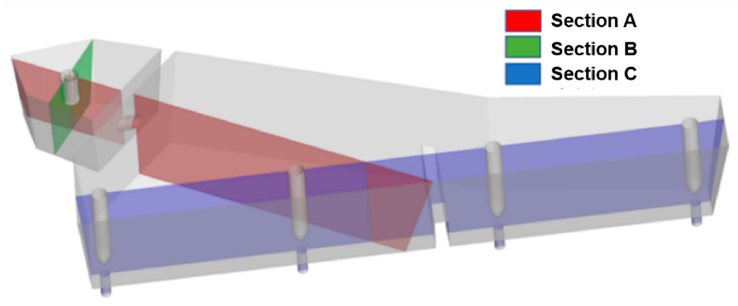
Figure 11. Diagrammatic sketch of three characteristic cross-sections in the tundish.